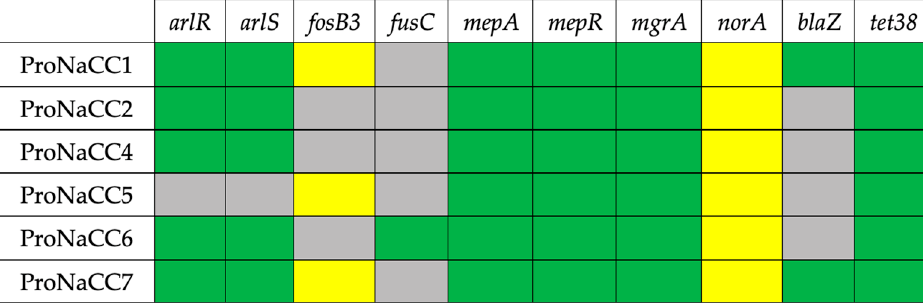
Figure 9. Genes related to antimicrobial resistance and their distribution among the six strains. The heatmap depicts the presence (green) or absence (grey) of genes. When mutations, such as internal deletions, were identified, they were highlighted in yellow. arlR : response regulator ArlR gene; arlS : signal transduction histidine-protein kinase ArlS gene; fosB3 : metallothiol transferase FosB gene; fusC : fusidic acid resistance gene; mepA : multidrug resistance efflux protein MepA gene; mepR upstream repressor of mepA gene; mgrA : transcriptional regulator gene for norA , norB , and tet38 ; norA : quinolone resistance protein gene; blaZ : β -lactamase penicillin resistance gene; tet38 : tetracycline efflux pump gene. The lanthionine-containing peptide antibiotic (lantibiotic) gene ( bsaA2 ) [77], was the